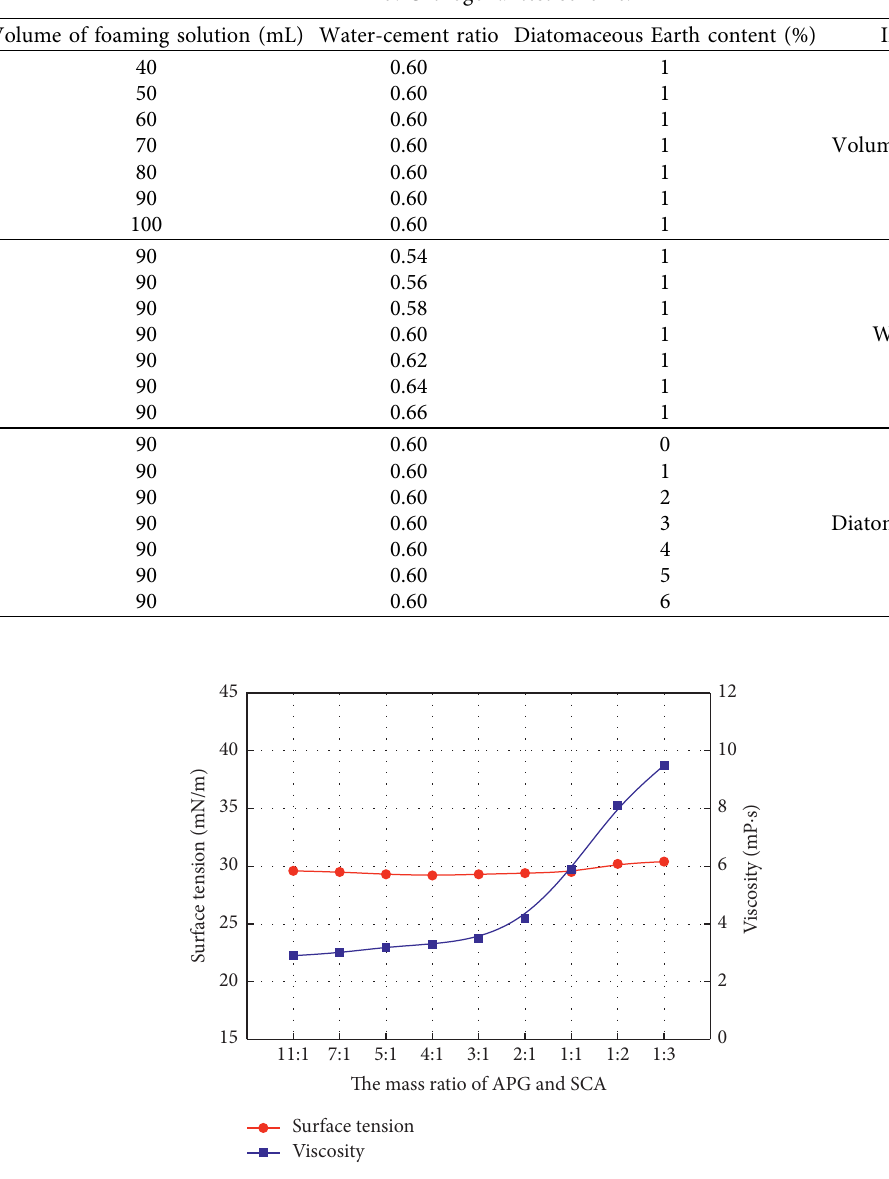
Figure 2: The curve of surface tension and viscosity under different surfactant mass